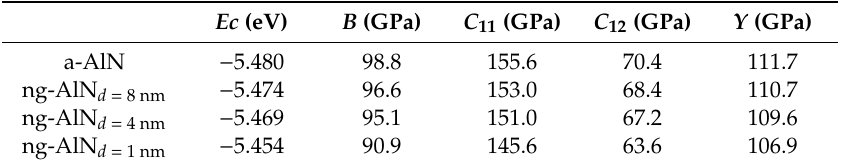
Table 1. Mechanical properties of a-AlN and ng-AlNs obtained with the Molecular dynamics simulation (MD) simulations. Notations: Ec (eV), cohesive energy; B (GPa), bulk modulus; C 11 and C 12 (GPa), elastic constant; Y (GPa), Young